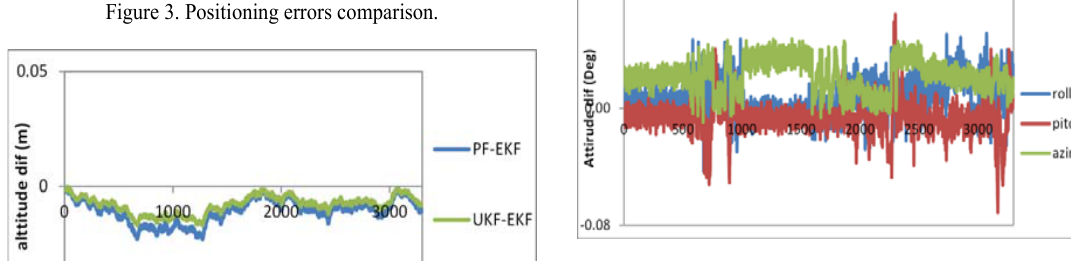
Figure 7. Attitude estimation results difference from DGPS/MEMS-based IMU attitude results